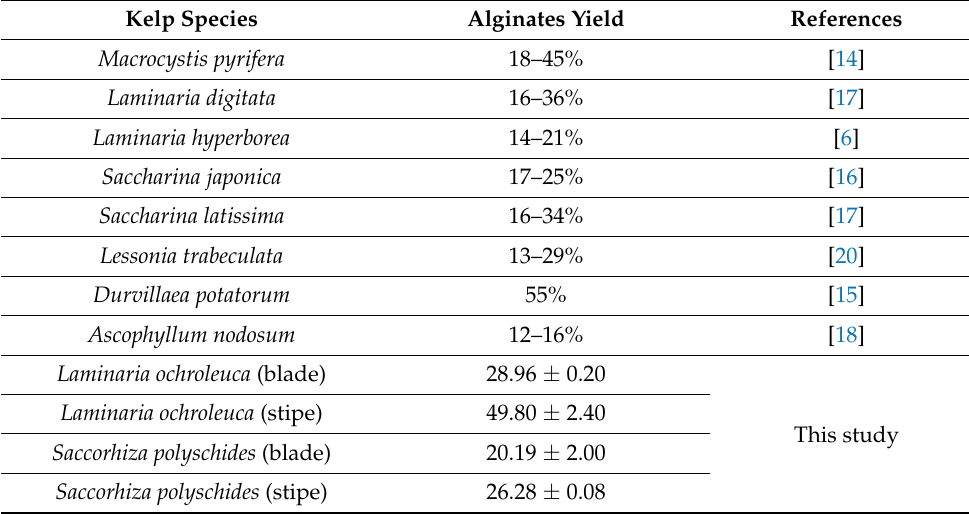
Table 2. Alginate yields of L. ochroleuca and S. polyschides (blades and stipes) compared to various kelp species. Kelp Species Alginates